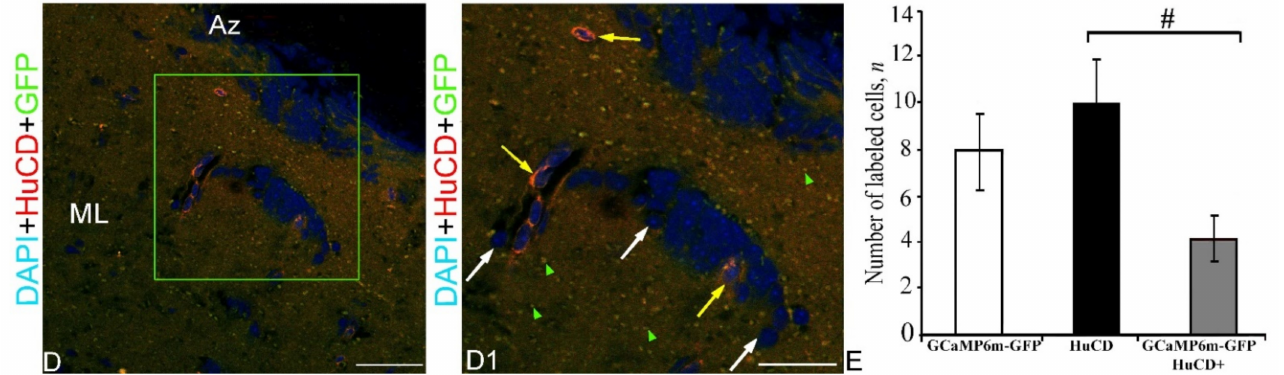
Figure 1. Z-stacks representing DAPI staining, localization of GFP and HuCD, and their co- localization in the cerebellum of juvenile chum salmon, Oncorhynchus keta , at 90 days after a single injection of the rAAV into the cerebellar body. ( A ) DAPI staining with a pictogram showing the dorso-medial region of the cerebellar body in a red box, dorsal matrix zone (DMZ) in inset, and apical zone (AZ). ( A1 ) A fragment of A3 (outlined by a white square), single rounded DAPI+ nu- clei (white arrows), elongated nuclei (pink arrows), and molecular layer (ML). ( A2 ) The enlarged fragment of AZ outlined by a white box in A1 and accumulation of heteromorphic nuclei (inset) with numerous nucleoli (white arrows). ( B ) Immunolocalization of green fluorescent protein GFP in granules (green arrowheads) and cells (green arrows) in AZ, accumulation of GFP+ granules (inset) in ML. ( C ) HuCD immunolocalization in AZ neurons (yellow box). ( C1 ) The enlarged fragment outlined by a yellow box in C and bodies of HuCD+ neurons (red arrows). ( D ) Co-localization of GFP and HuCD in AZ neurons (green box). ( D1 ) The enlarged fragment outlined by a green box in D, DAPI-stained nuclei (white arrows), cytoplasmic colocalization of GFP/HuCD+ neurons (yellow arrows), and GFP+ granules (green arrowheads). Laser scanning confocal microscopy. Scale bar: ( A ) 100 µ m, ( A1 , B , C , D ) 50 µ m, and ( A2 , C1 , D1 ) 50 µ m. ( E ) One-way ANOVA showing the relative distribution of GFP, HuCD, and GFP/HuCD immunolabeled cells of the dorso-medial region of the cerebellum of juvenile O. keta ; data are presented as mean ± standard deviation (M ± SD). Significant intergroup differences were found in the group of GCaMP6m-GFP and HuCD+ cells (# <0.05) ( n = 5 in each